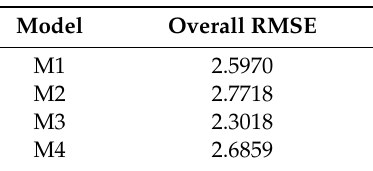
Table 5. The overall root mean square error (RMSE) of all four